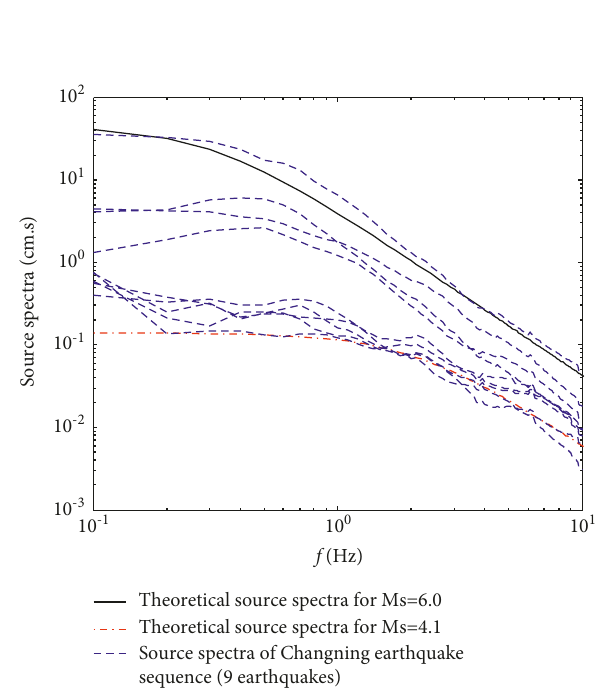
Figure 11: Seismic source displacement spectra versus the theory model of the Changning seismic